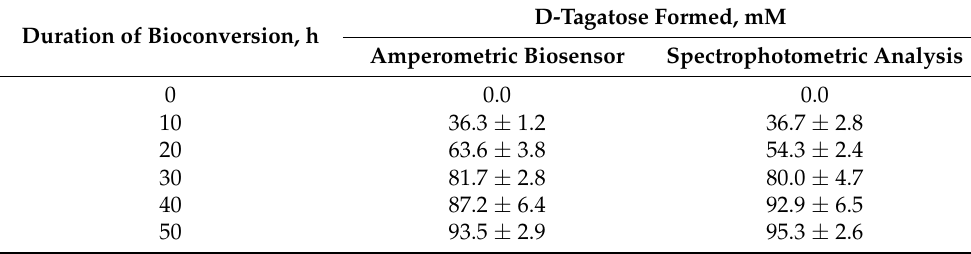
Table 2. Comparison of D-tagatose concentrations formed during isomerization of D-galactose obtained using two methods: amperometric biosensor vs.